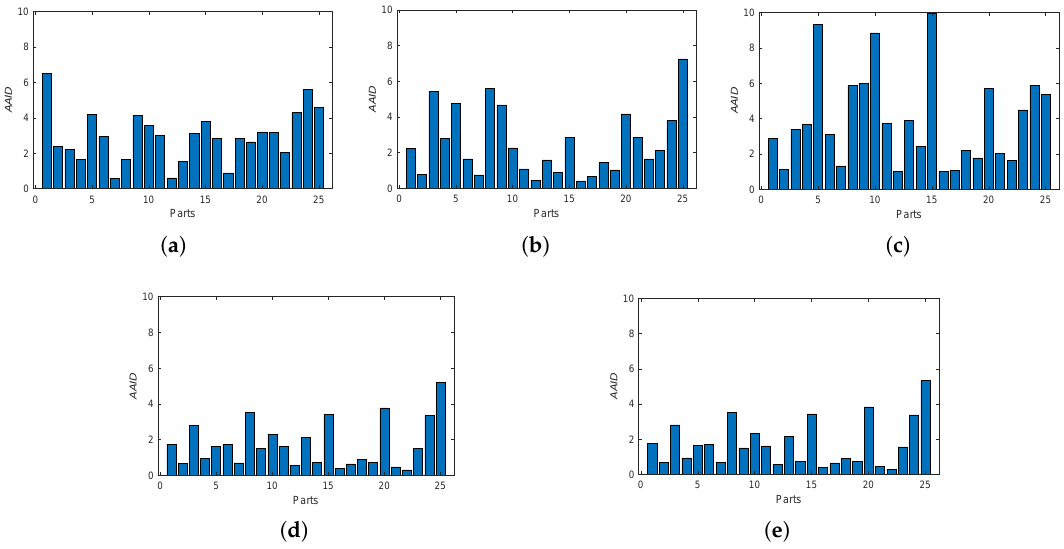
Figure 13. Spatial partition of the AAID evaluation for Foosball image. ( a ) BRISK. ( b ) KAZE. ( c ) SURF. ( d ) Proposed (Demp). ( e ) Proposed (PCR6).